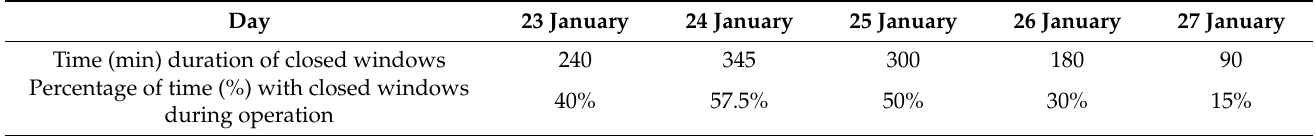
Table 6. Time duration of closed windows during the operation of the automation system.